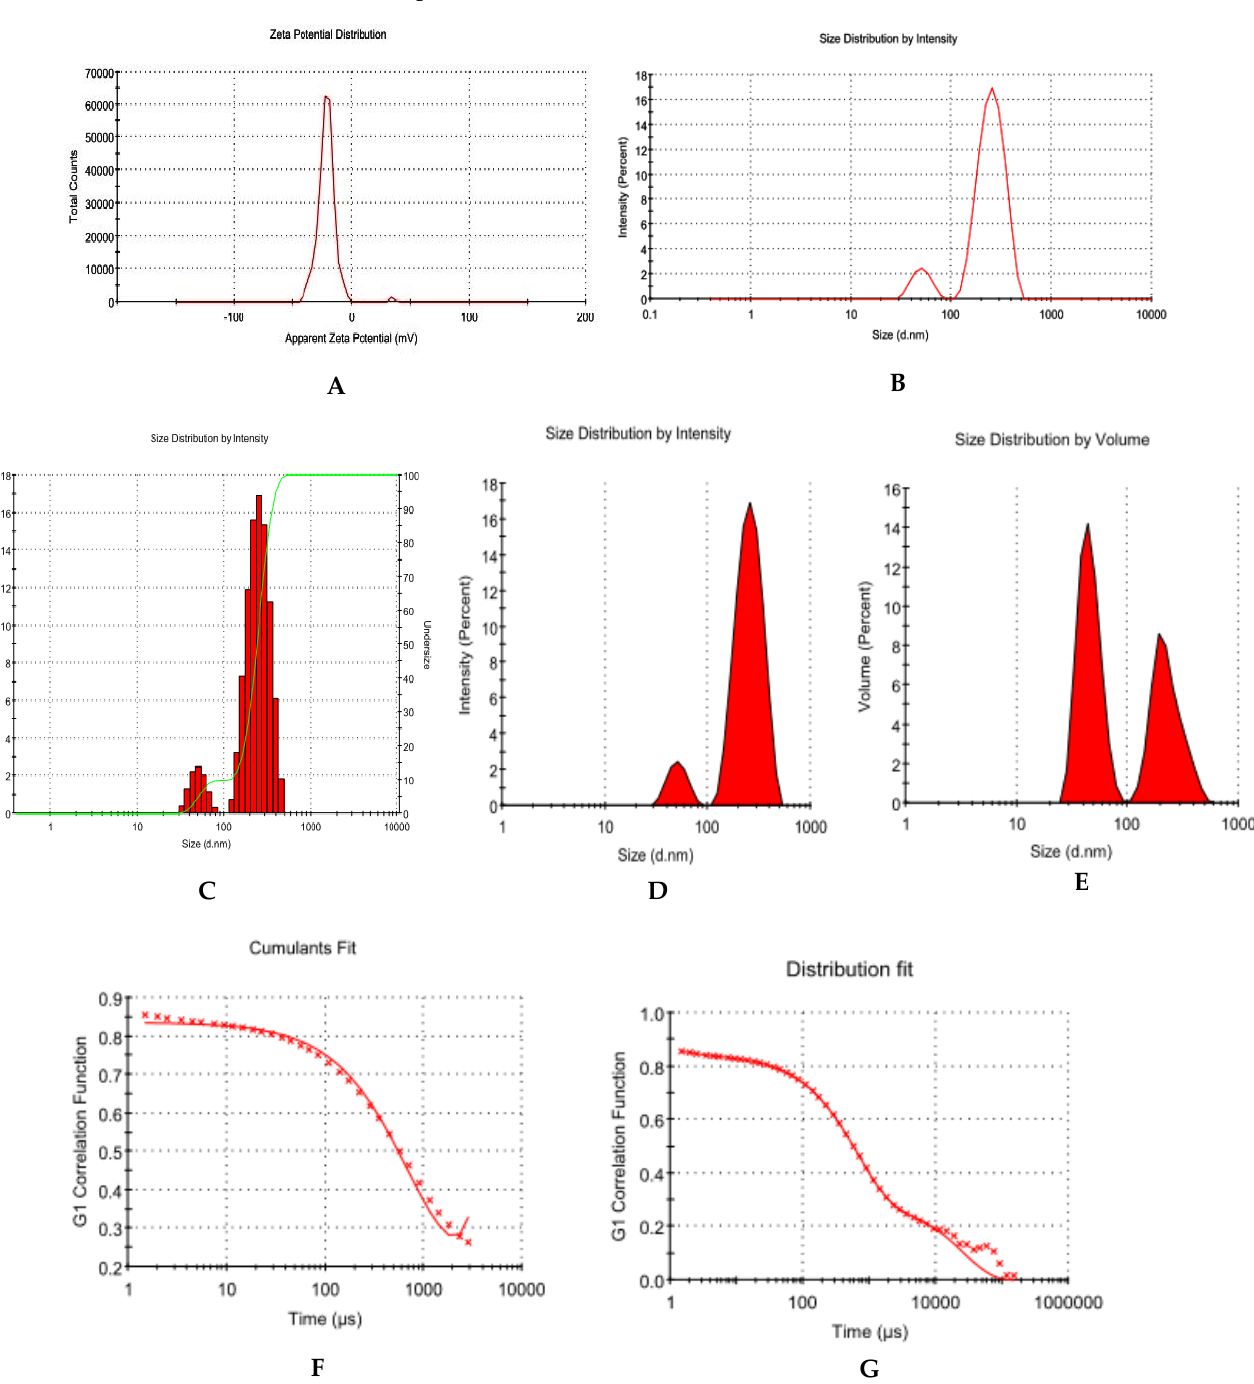
Figure 1. Physical characterization of lyophilized amikacin sulfate loaded dextran nanoparticles. ( A ) Zetapotential analysis ( B ) Size distribution of nanoparticles through particle intensity. ( C ) Various particle size distribution analysis through the percent intensity ( D ) Particle Size distribution analysis through intensity ( E ) Particle Size distribution analysis through volume ( F ) Cumulative fit of particulate colloidal system ( G ) Particle distribution fit of the particulate colloidal system.